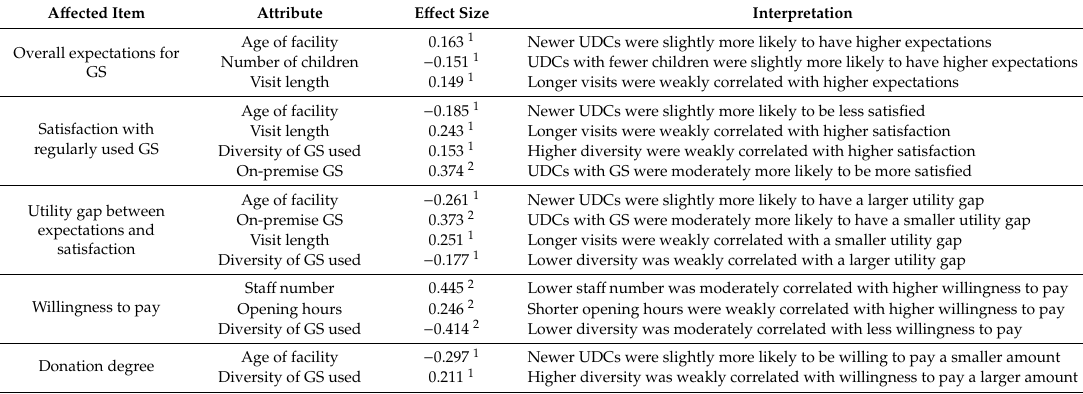
Table 6. Significant e ff ects of UDC attributes on caregivers’ perception of and willingness to pay for GS access ( p < 0.05).